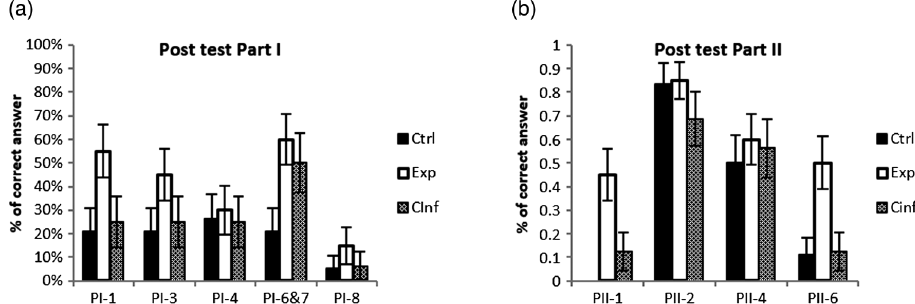
FIG. 12. Percentage of correct answer (score ¼ 3 ) for each electric potential problem in the post-test. (a) Percentage of correct answer for problems in part I of the post-test. (b) Percentage of correct answer for problems in part II of the post-test.